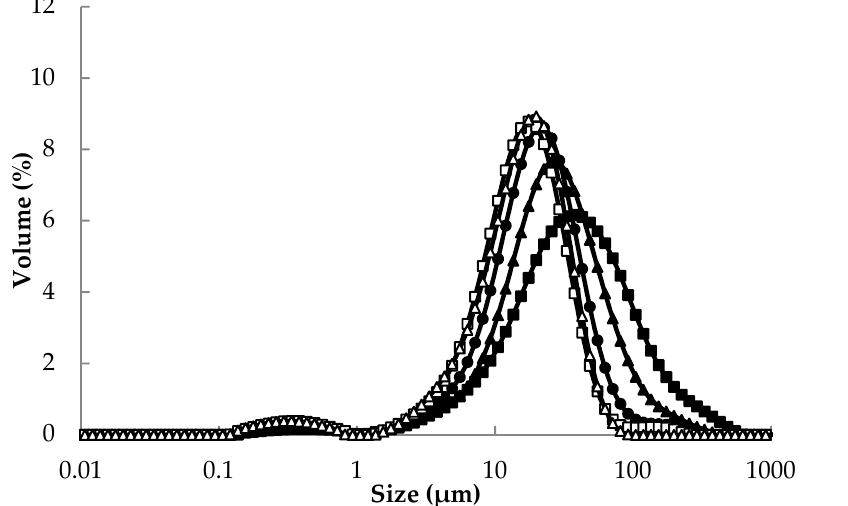
Figure 2. Particle size distribution of milk protein concentrate (MPC) 85 ( ■ ), MPC75 ( ▲ ), MPC65 ( ● ), MPC55 ( □ ), and MPC40 ( ∆ ) powders. Table 2. Particle density (p p ), loose bulk density (p b ), tapped bulk density (p t ), volume of interstitial air (V ia ), volume of occluded air (V oa ), particle size below which 90% of material volume exists (D 90 ), and the volume weighted mean particle diameter (D [4,3] ) values for milk protein concentrate (MPC) powders. MPC